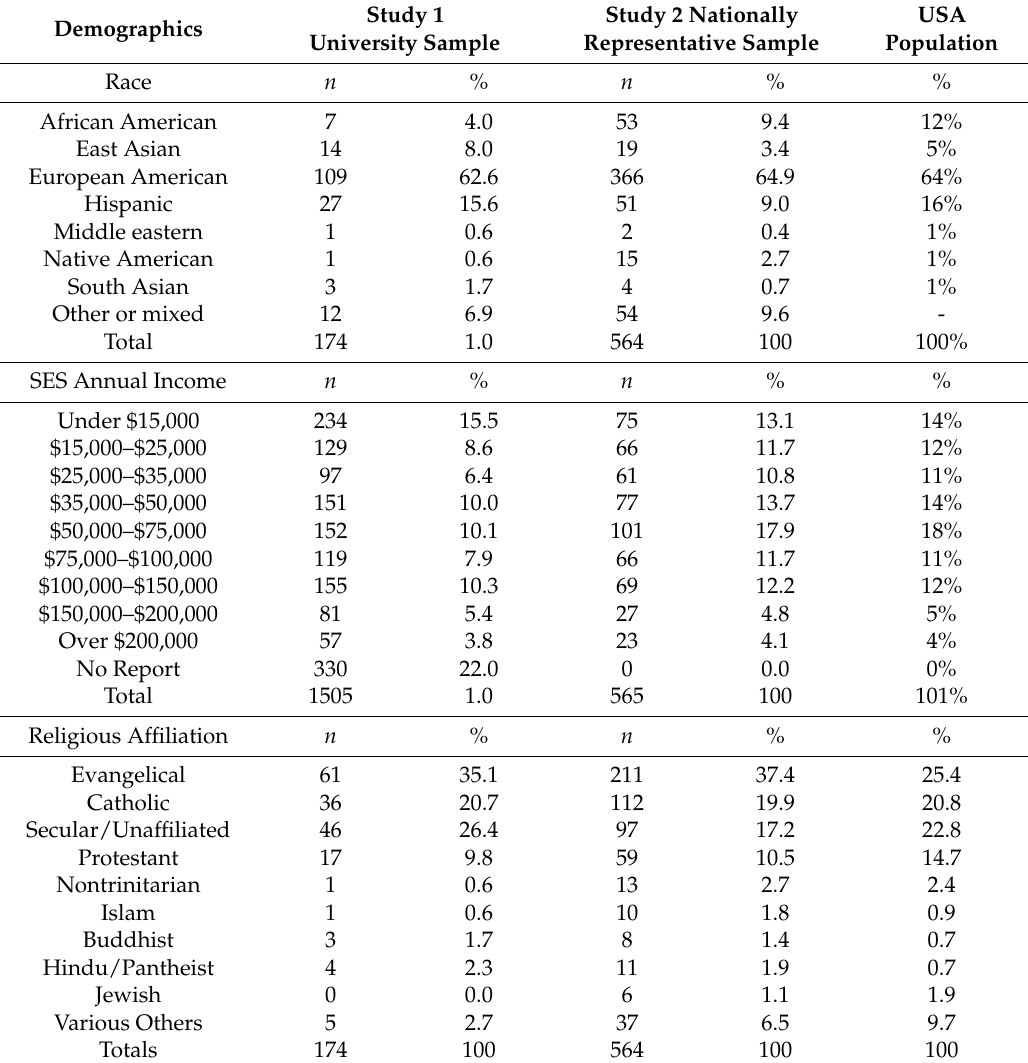
Table 1. Descriptive Statistics of Racial Demographics, Socioeconomic status, and Religious Affiliation of both